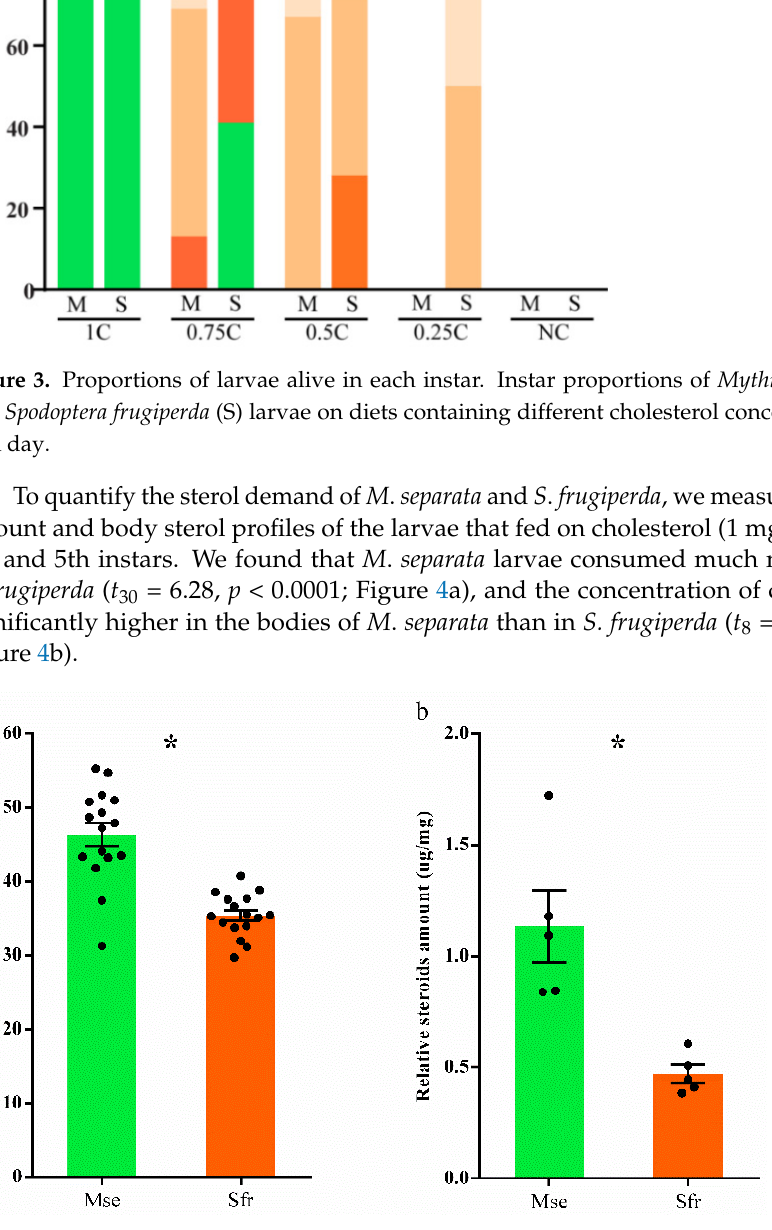
Figure 4. Performance of Mythimna separata (Mse) and Spodoptera frugiperda (Sfr) larvae on the diet containing 1 mg/g cholesterol. The feeding amount ( a ) was recorded during two stadia (the 4th and 5th instars). Upon reaching the 6th instar, the insects were sacrificed, and the body relative steroids amount ( b ) was measured by GC/MS technology. Cholesterol was the only sterol/steroid found in these samples. Data are calculated from five biological replicates and shown as means ± standard errors. * represents a significant difference at p < 0.05.